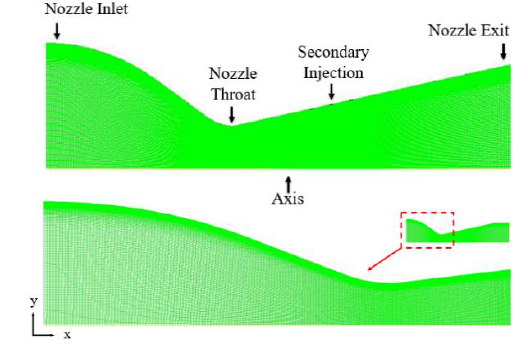
Figure 4. Mesh B — used for CFD simulations. Figure 4. Mesh B—used for CFD simulations. Table 5. Mesh properties.